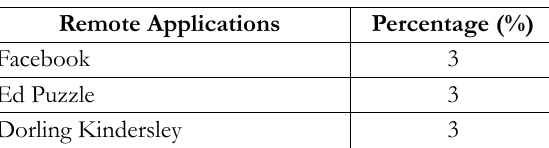
Table 9. Percentage of teachers’ responses for remote applications (Questionnaire)